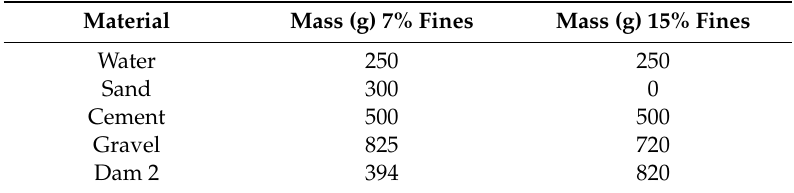
Table 4. Mortar mix with 7% and 15% fine particles from Dam 2 mine